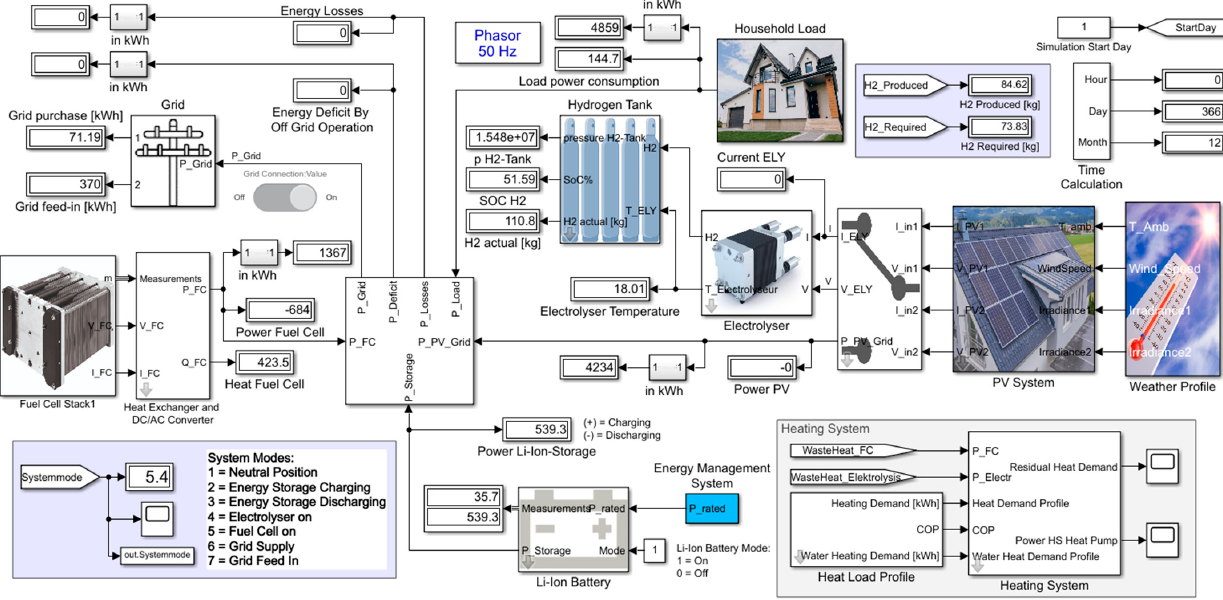
Figure 4. Simulink model of the overall household energy system (image sources: [28,29]).